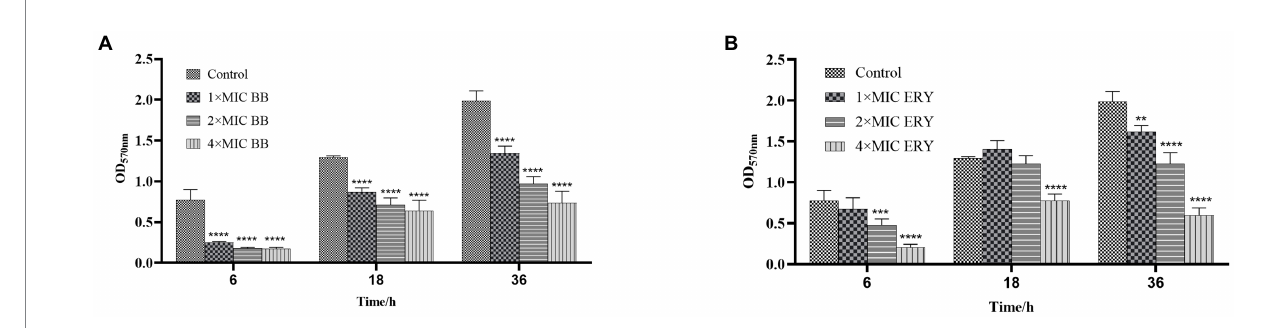
FIGURE 3 The quantity of biomass at each stage of biofilm formation of SEP-05. (A) SEP-05 treated with Disaspidin BB; (B) SEP-05 treated with erythromycin. *means p < 0.05, **means p < 0.01, ***means p < 0.001, ****means p <